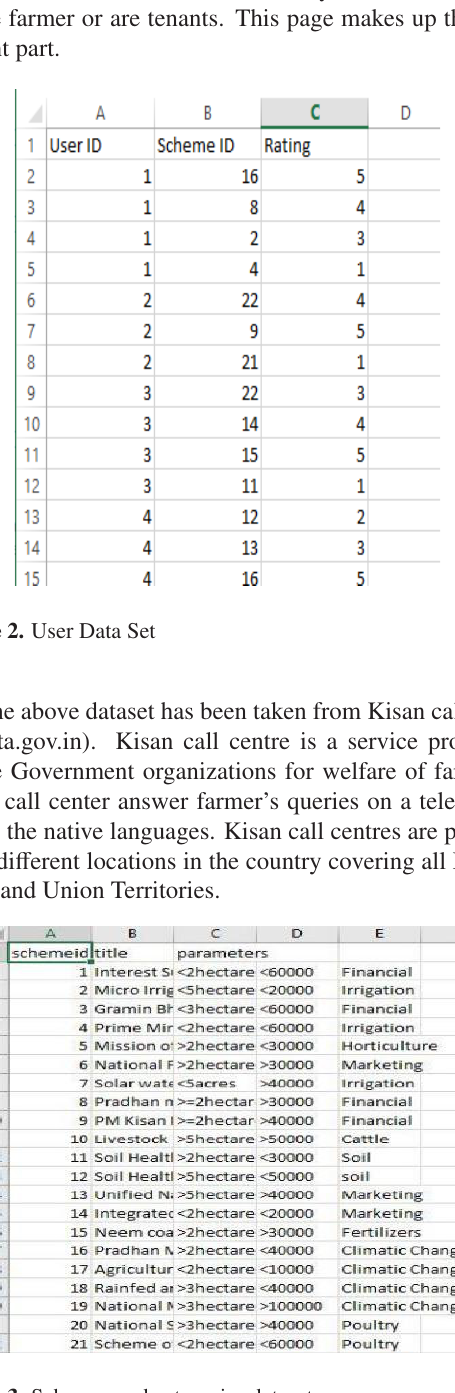
Figure 3. Schemes and categories dataset Figure 1. Block Diagram of CRSAS